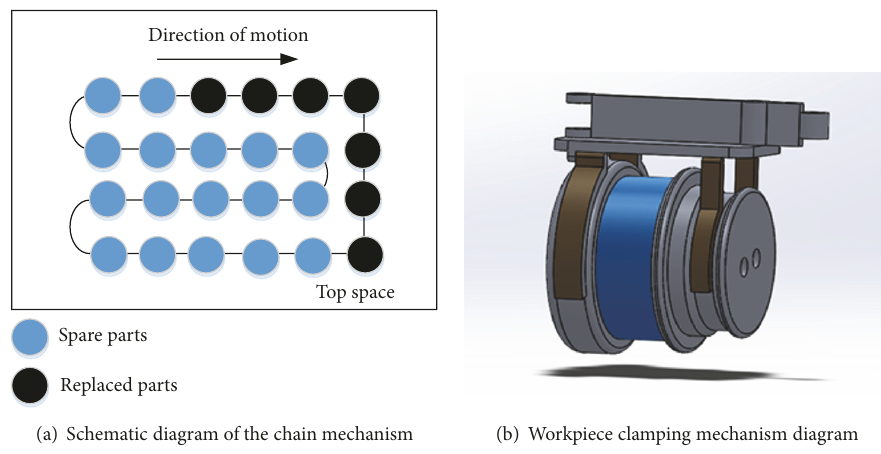
Figure 5: Schematic diagram of the chain hanging mechanism.